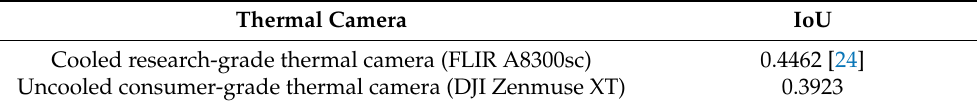
Figure 16. Nebraska bridge level-set thermal image result. ( a ) results of the consumer-grade camera with a boundary threshold of 0.3 (Partially adopted and modified from [31]), ( b ) results of the research-grade camera (Adopted and modified from [24]). Table 7. The Nebraska bridge inspection result: IoU values of both consumer and research-grade thermal